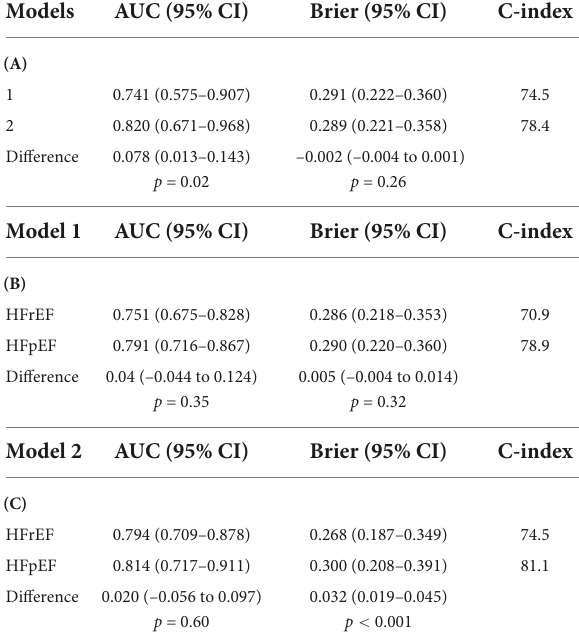
TABLE 3 Model comparison with model-specific area-under-curve (AUC) and Brier score and delta score between pairs of models in